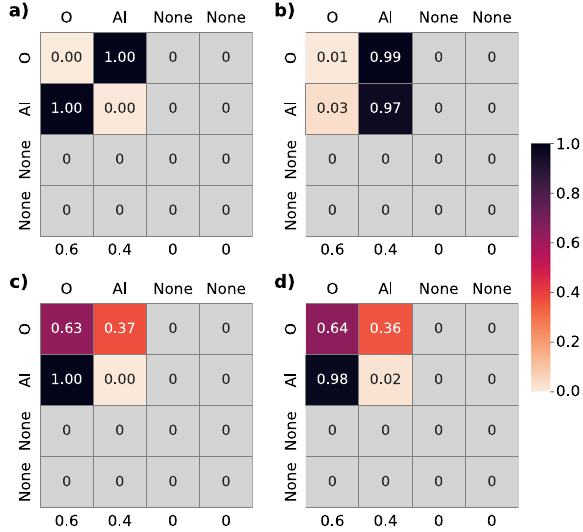
Fig. 2 Visualization of self-attention in one compound. Displayed are the four attention heads ( a – d ) from the fi rst layer of a CrabNet model trained on mp_bulk_modulus and evaluated on the composition Al 2 O 3 . Each row represents an element in the system. Each column represents an element being attended to. Each element ’ s fractional amount is shown on the x -axis. The values in the attention matrix are scores representing element-element interactions for the compound. As an example, in head a , Al 0.4 and O 0.6 are attending strongly to each other, with attention scores of 1.00 between these two